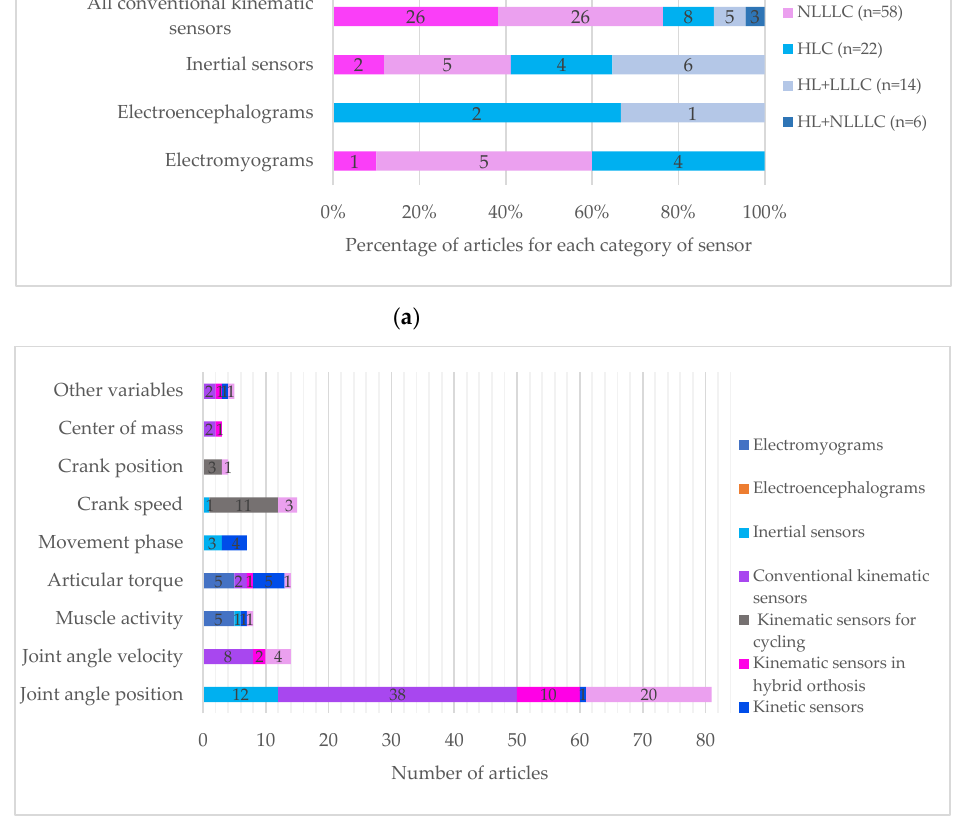
Figure 7. Control strategies description: ( a ) Control strategies distribution depending on the type of sensor; ( b ) Choice of the controlled variable regarding the type of sensor. LLLC: Linear low-level control. NLLLC: Nonlinear low-level control. HLC: High-level control. HLC+LLLC: High-level control and linear low-level control. HLC+NLLLC: High-level control and nonlinear low-level control. Table 2. Linearity of the control strategy of the three most recent sensors. Type of Sensor (n = Number of Articles Between 2012 and 2022) Number of Articles with Nonlinear Controller Kinematic sensors for cycling (n = 11) 8 Inertial sensor (n = 14) 4 * Electromyography (n = 6) 4 Total recent articles (n = 62) 37 * Indicates that the result is significatively different from the overall tendency (using χ 2 statistical test with α = 0.01) .